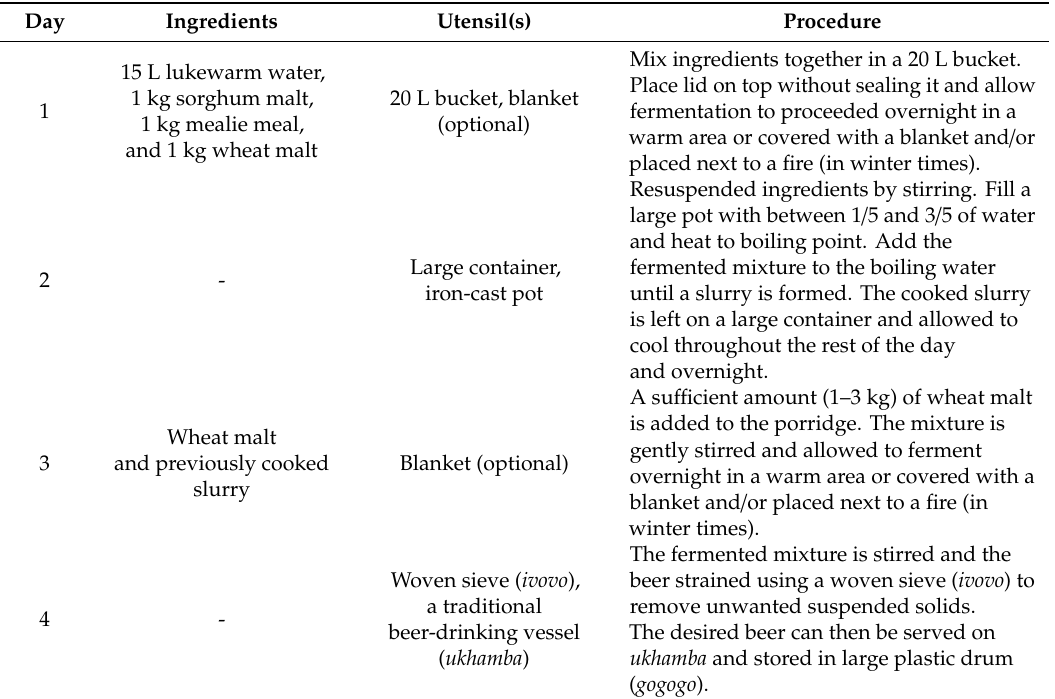
Table 1. Summary of the household method of making umqombothi